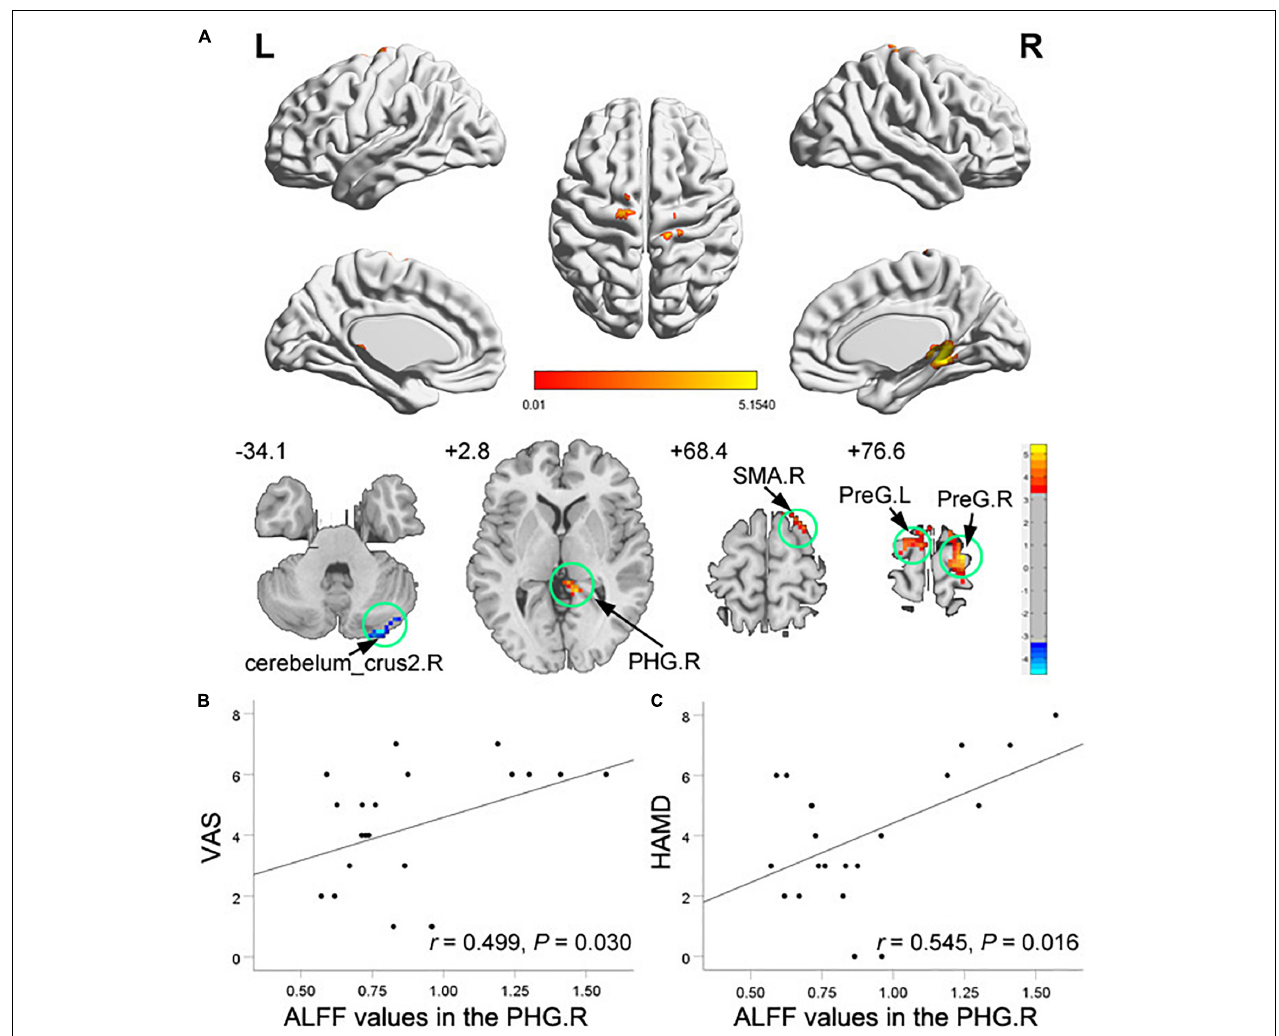
FIGURE 1 | Clusters showing amplitude of low-frequency fluctuation (ALFF) changes in temporomandibular disorders (TMD) patients as compared to that in healthy controls (A) , and correlations of abnormal ALFF values with visual analog scale (VAS) scores (B) and HAMD scores (C) . The significance threshold was set at voxel-level P < 0.001 and cluster-level P < 0.05 (GRF corrected). Blue color denotes relatively lower ALFF values in the TMD group, red color denotes relatively higher ALFF values in the TMD group, and the color bar indicates the t-value from the two-sample t -test between the TMD group and HCs. There were